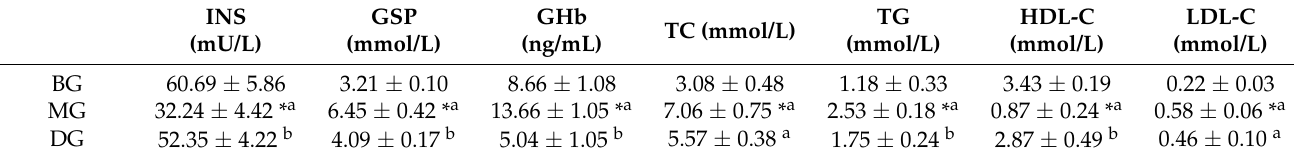
Table 1. Effects of hydroxy-alpha-sanshool on key serum indexes in mice.